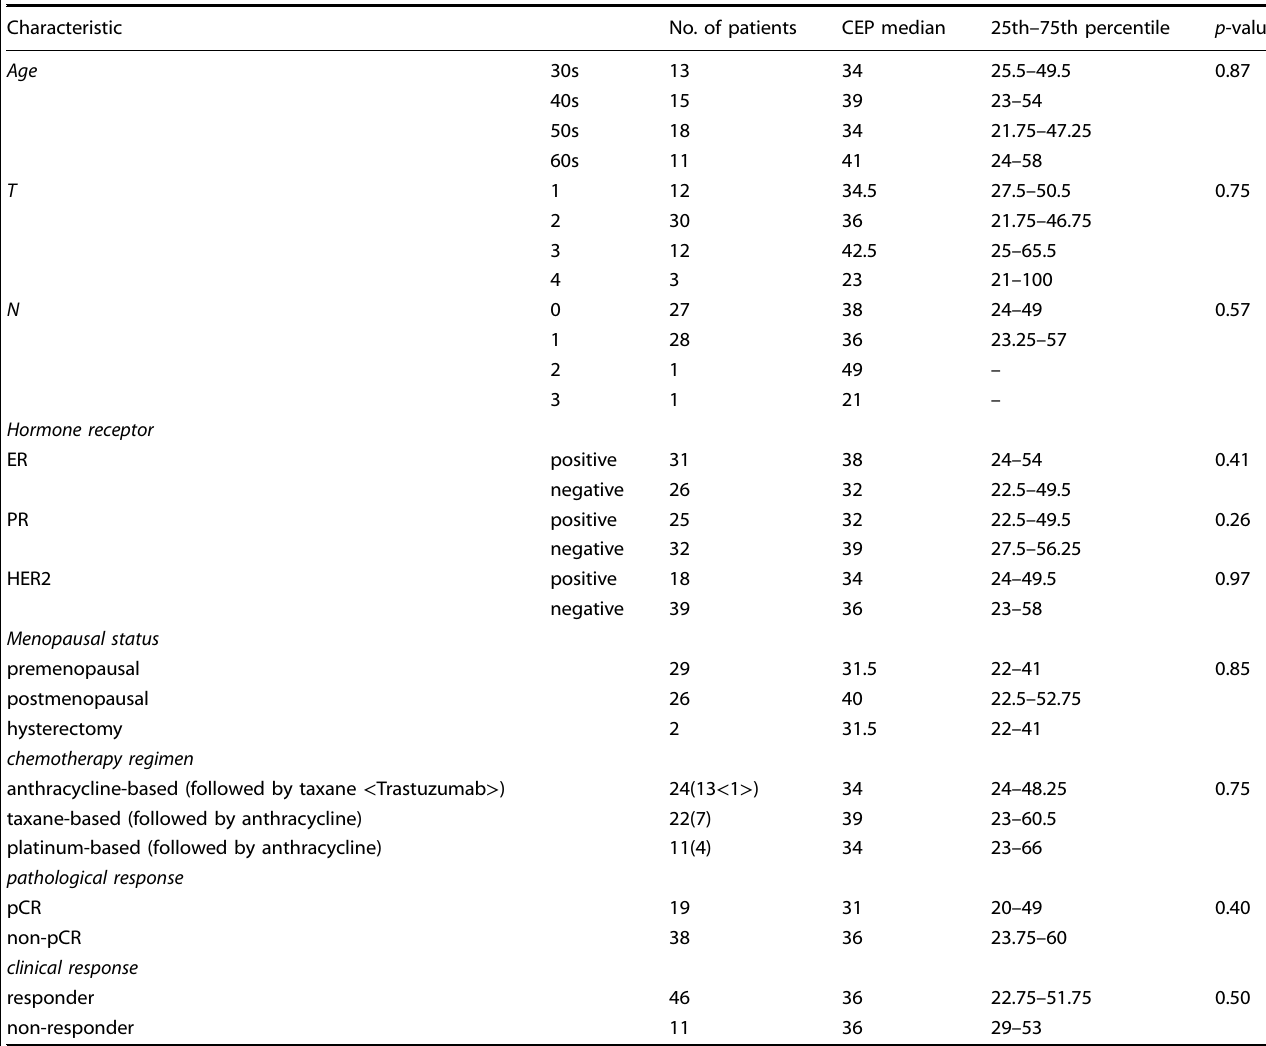
Table 1. Patient clinical and pathological characteristics and CEP counts at baseline ( n = 57)